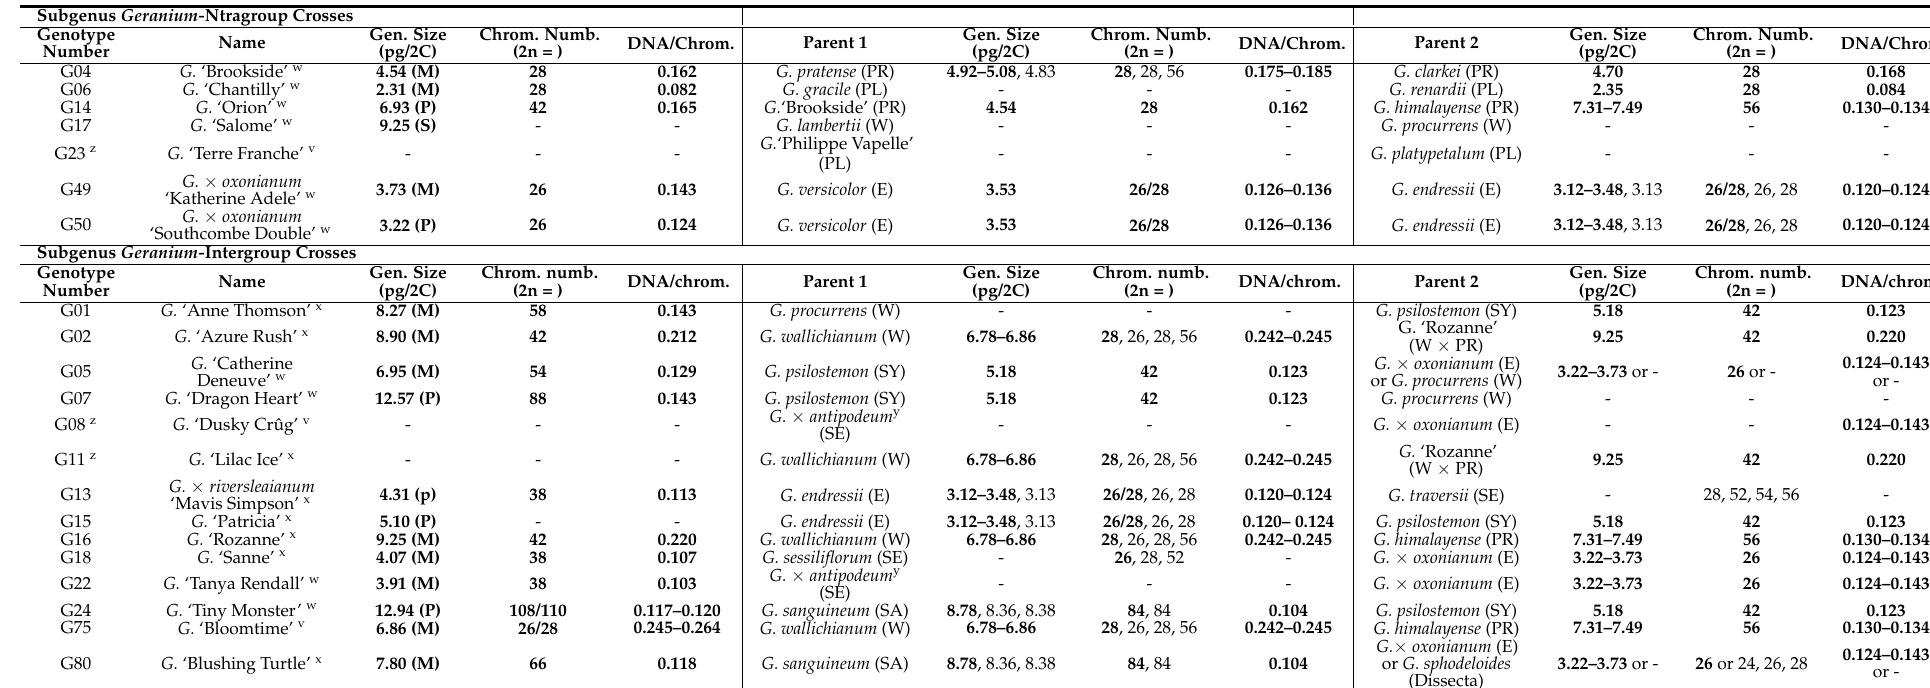
Table 2. Intra- and intergroup hybrids together with parental background and the hybrids’ respective genome sizes (Gen. size (pg/2C)), chromosome numbers (Chrom. numb.) and DNA/chromosome (DNA/chrom. (pg/chromosome)). The plant species used as internal standard is mentioned with the genome size ( Zea mays (M), Pisum sativum (P) and Glycine max (S)). The figures in bold were obtained from our study; the others mentioned come from the literature. The abbreviations for the taxonomical groups are the following: C = Cinereum, E = Endressii, M = Maculatum, MA = Macrorrhizum, P = Phaeum, PA = Palustre, PL = Platypetalum, PR = Pratense, SA = Sanguineum, SE = Sessiliflorum, SY = Sylvaticum, W =